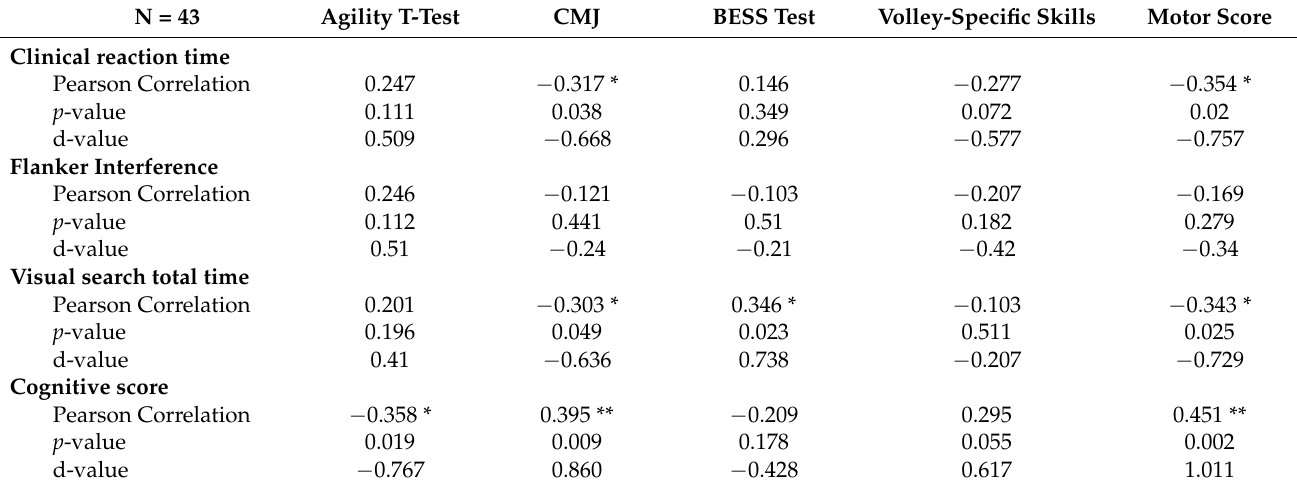
Table 2. Correlations between sport-specific physical performance (volleyball-specific skills, COD, vertical jump, balance) and cognitive skills.